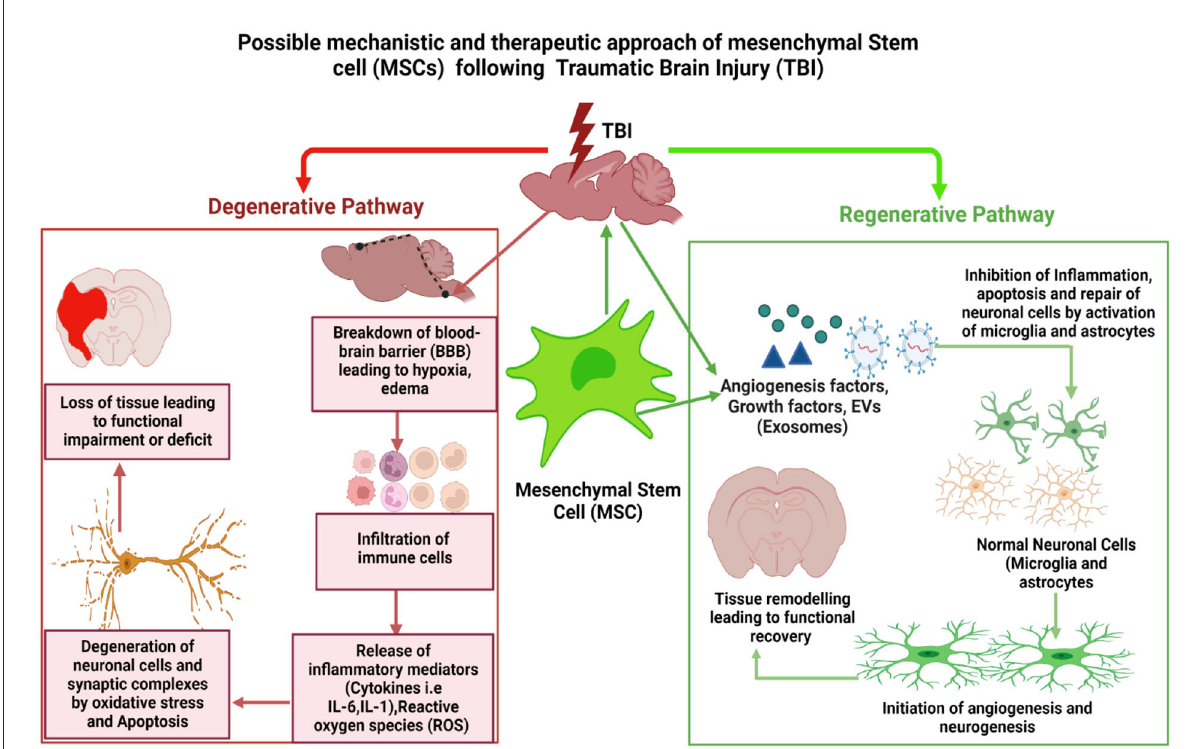
FIGURE2 Possible mechanistic and therapeutic approach of mesenchymal stem cell (MSCs) following traumatic brain injury: TBI breaches the blood–brain barrier (BBB), resulting in a cascade of reactions such as hypoxia, edema, cellular infiltration, and release of inflammatory mediators by immune cell. This causes an increase in the formation of reactive oxygen species (ROS), which causes oxidative stress, neuroinflammation, and apoptosis, all of which damage neurons and activate astrocytes and microglia. Activated astrocytes and microglia set off inflammatory processes that further damage neurons and other cells, leading to tissue loss and functional deficiencies over the long term. When we use MSCs to treat traumatic brain injury (TBI), MSCs and their released exosomes can cross the blood–brain barrier (BBB) and migrate steadily to the damaged area of the brain. There, they release a variety of cytokines, including neurotrophic factors and vascular regeneration factors, to promote nerve and blood vessel repair and regeneration, leading to the restoration of the brain microvascular system and its function. Figure created with